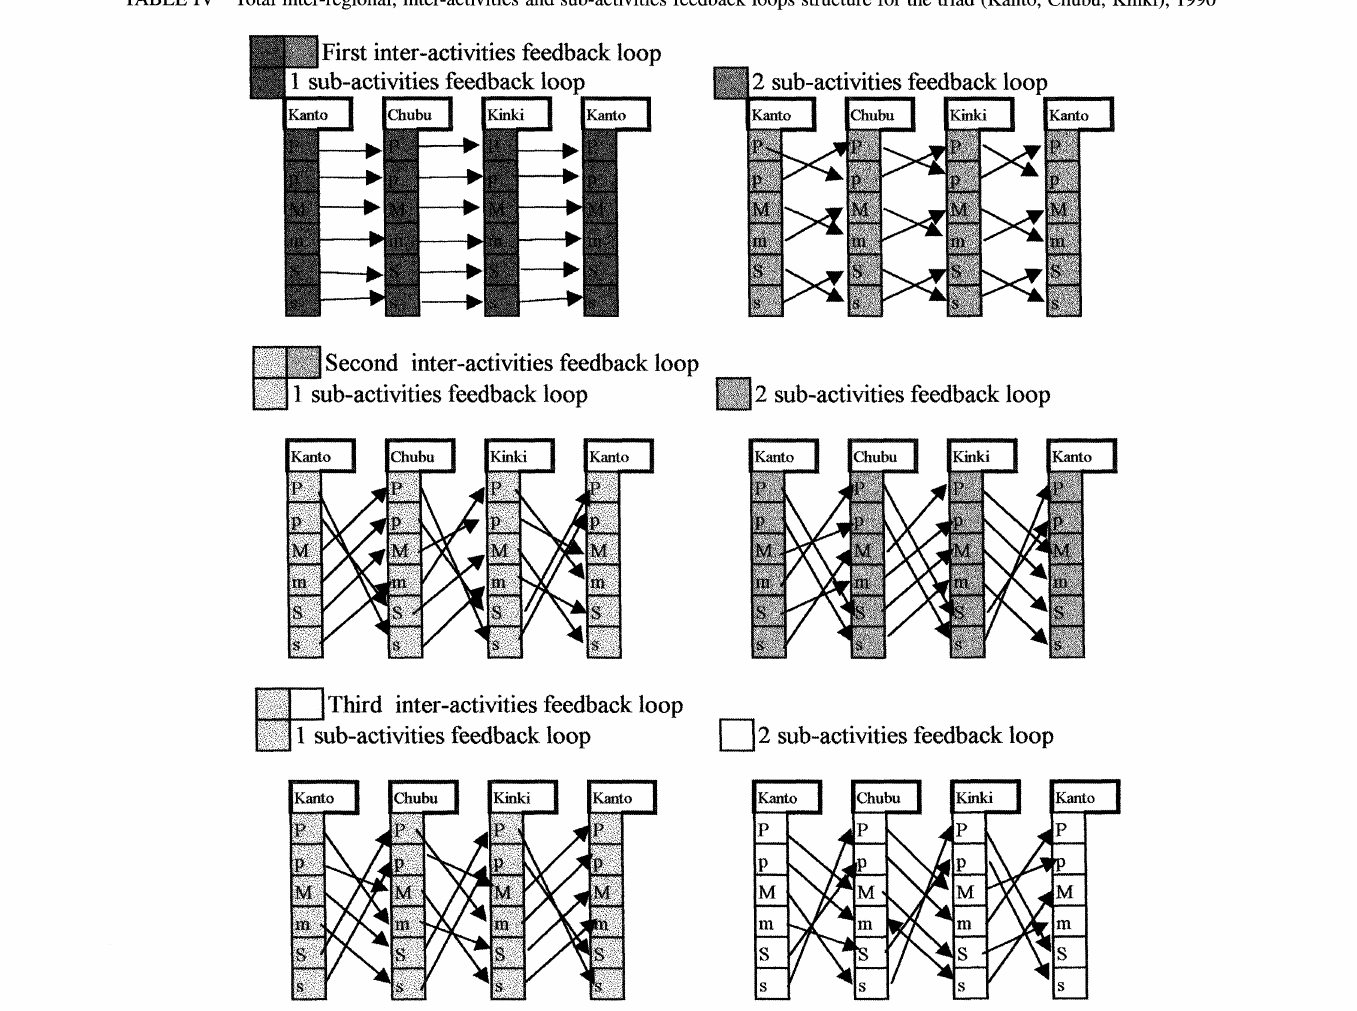
TABLE IV Total inter-regional, inter-activities and sub-activities feedback loops structure for the triad (Kanto, Chubu, Kinki),